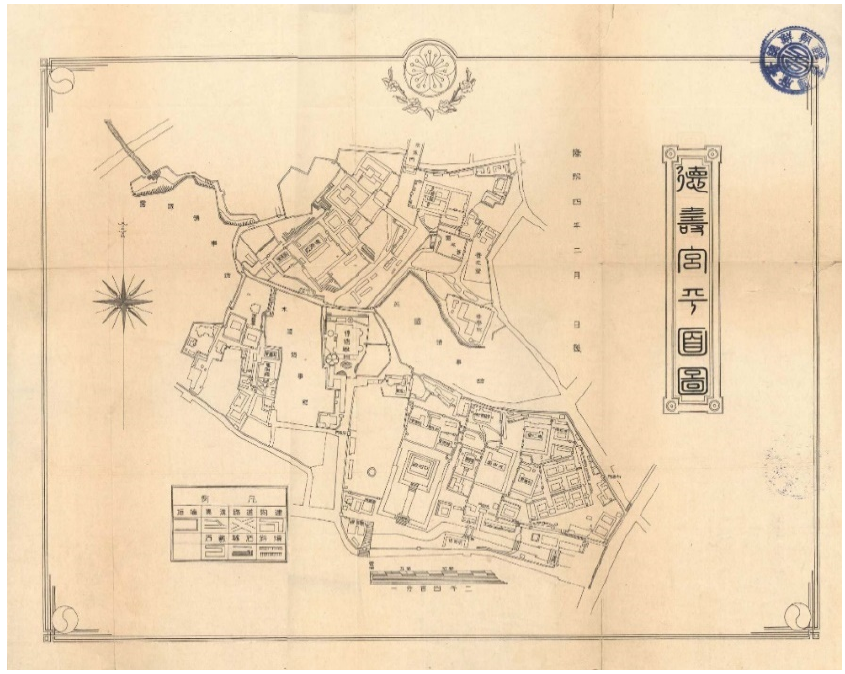
Figure 5. Plan of Tŏksugung in 1910. After (Oda 1938). Courtesy of National Library of Korea.